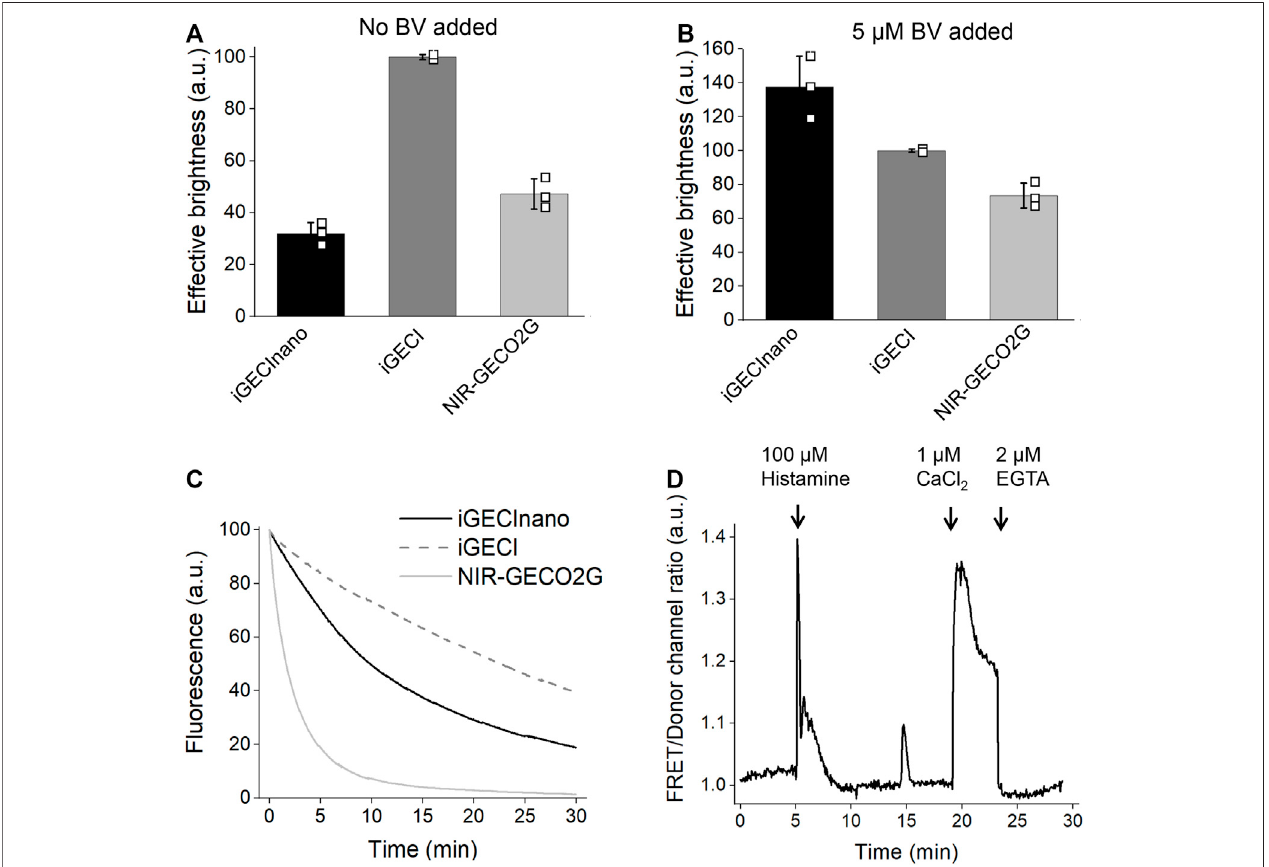
FIGURE 3 | Characterization of iGECInano in live human HeLa cells. (A,B) Comparison of iGECInano, iGECI, and NIR-GECO2G brightness in live HeLa cells in the absenceofBV (A) and inthepresenceof5 μ M BV (B) measured using fl owcytometry andnormalizedoniGECI fl uorescence.The640 nm laserwasused forexcitation, and a 647 nm long-pass edge fi lter to detect fl uorescence. Fluorescence intensities were normalized to the absorption ef fi ciencies of the indicators at 640 nm. In (A,B) , n = 3 individual experiments. (C) Photobleaching curves of iGECInano, iGECI, and NIR-GECO2G in live HeLa cells excited using a 605/30 nm bandpass and imaged using a 647 nm long-pass fi lter. Photobleaching data were normalized to the absorption ef fi ciencies of indicators at 605 nm. 5 μ M exogenous BV was supplied 24 h before the experiment. n = 5 cells. (D) Typical Ca 2+ transients reported by iGECInano in live HeLacells. Ratio changes ofthe FRET acceptor (ex. 605 nm, em. 725/ 40 nm) to the donor (ex. 605 nm, em. 680/20 nm) fl uorescence intensities upon treatment with 100 μ M of histamine, followed by changing the media to one containing 10 μ M ionomycin and 1 mM Ca 2+ and then 2 mM